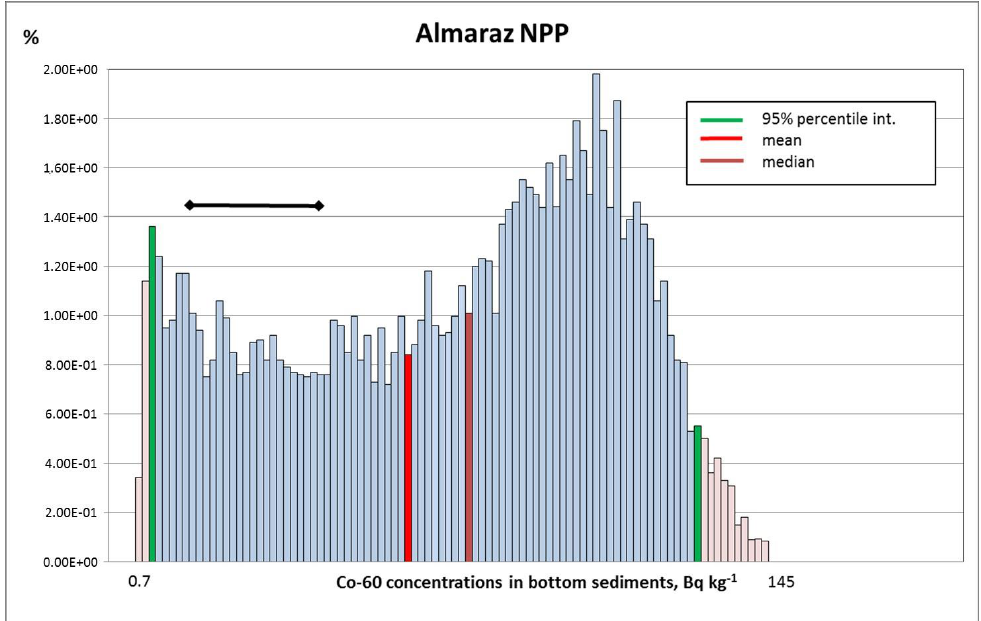
Figure 1. Co-60 activity concentrations calculated in bottom sediments (Bq kg − 1 ) at Arrocampo reservoir (Almaraz NPP). The range of the published measurements is represented with the black